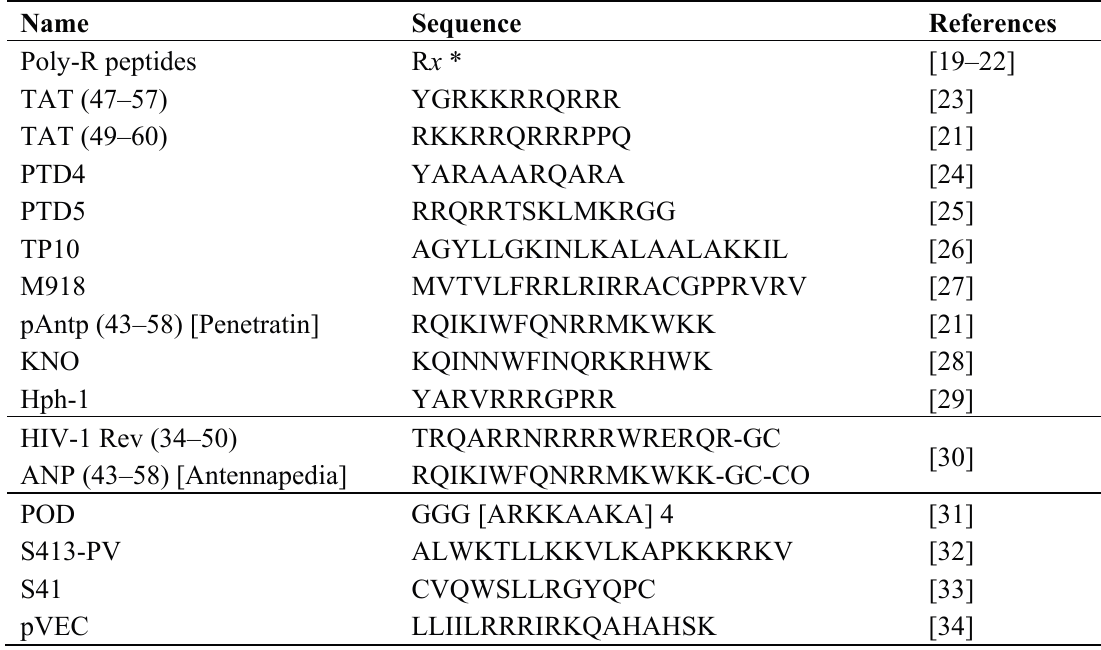
Table 1. Representative